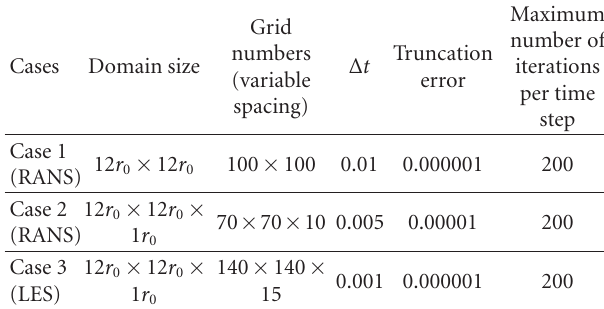
Table 1: Simulation parameters for di ff erent